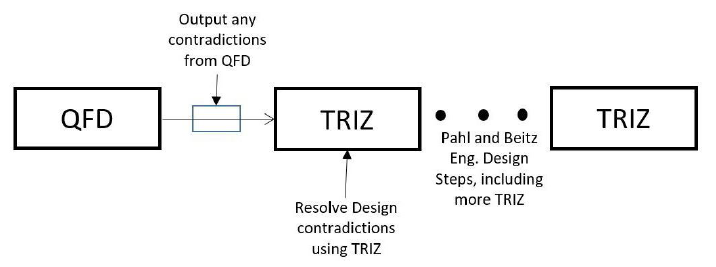
Figure 1. Integration of QFD and TRIZ [22].